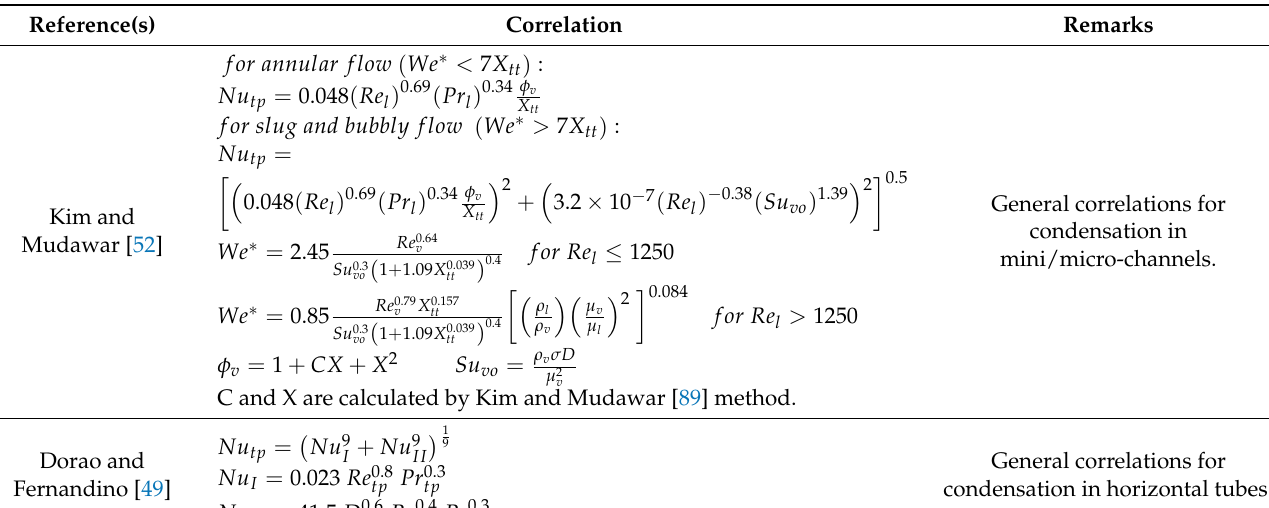
Table 3. Correlations for predicting the HTC during condensation.